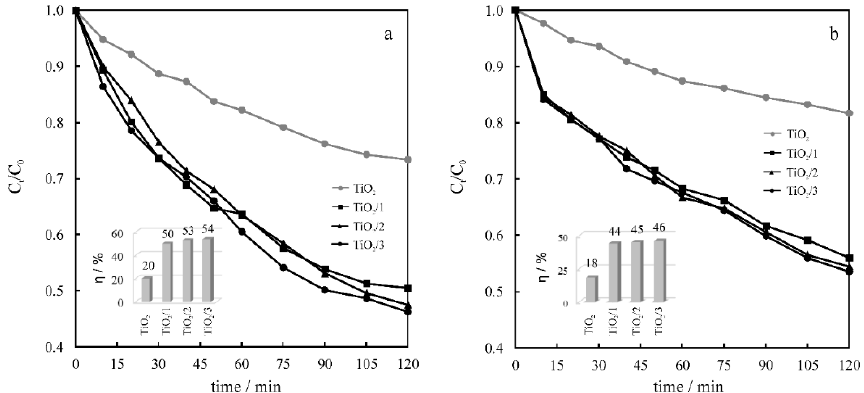
Figure 8. The decrease of phenol ( a ) and methylene blue ( b ) relative concentrations, and the efficiencies (insets) of their photocatalytic degradation in the presence of TiO 2 and the given composites.